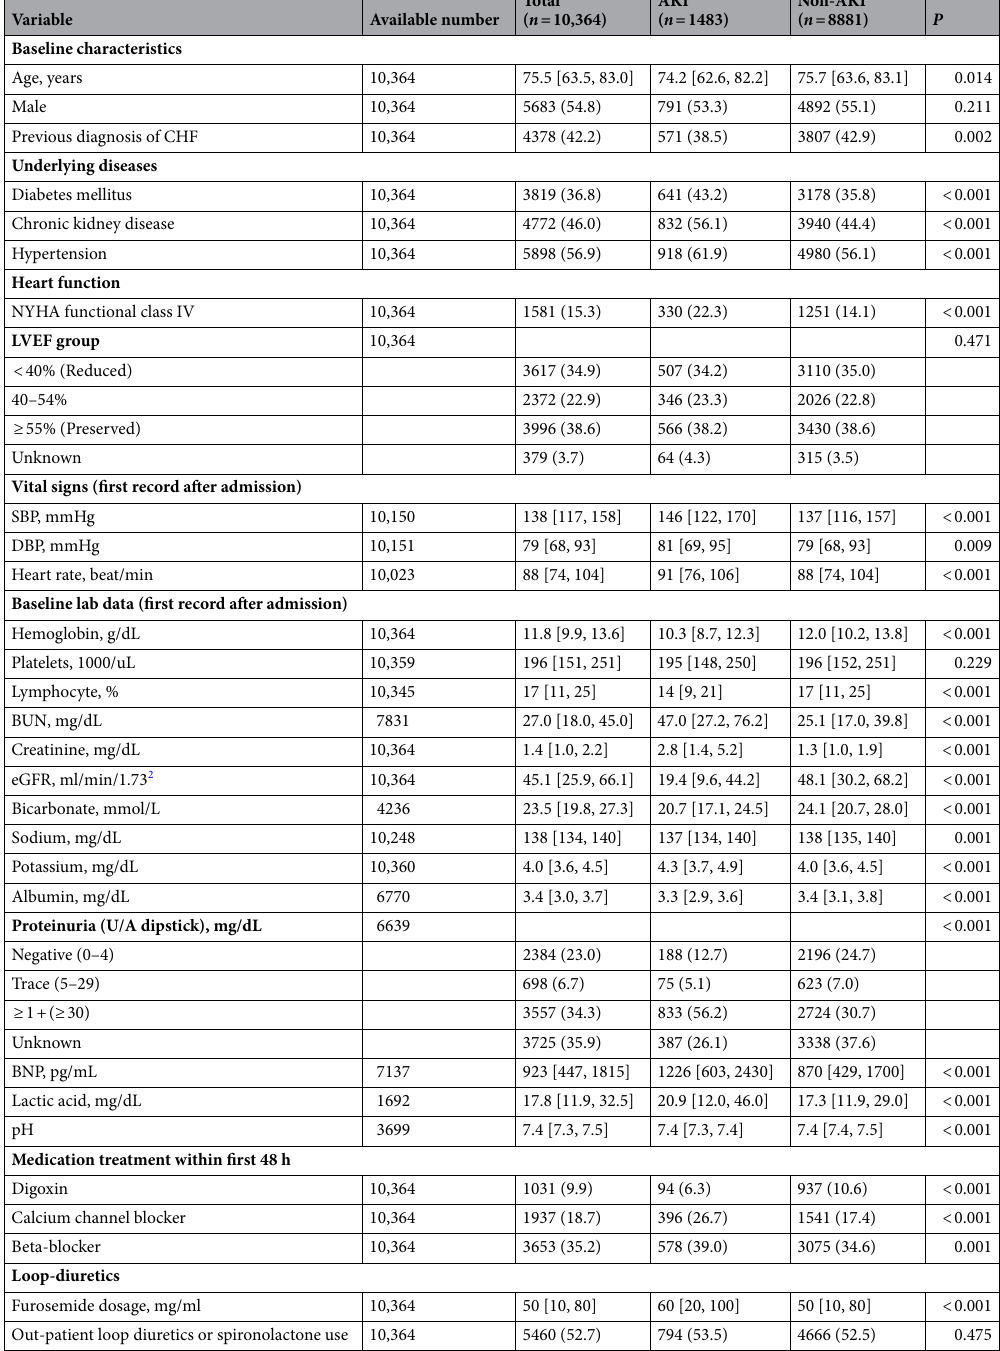
Table 2. Baseline characteristics of patients with and without AKI. AKI acute kidney injury; BNP B-type natriuretic peptide; BUN blood urea nitrogen; CHF congestive heart failure; DBP diastolic blood pressure; LVEF left ventricular ejection fraction; NYHA New York Heart Association; SBP systolic blood pressure; eGFR estimated glomerular filtration rate. Data are given as frequency (percentage) or median (25th, 75th percentiles). *CHF was defined by ICD code recorded in outpatient clinics or previous admission. † CKD was defined by combination of the ICD code in outpatient clinics or previous admission and the eGFR lower than 60 before the index